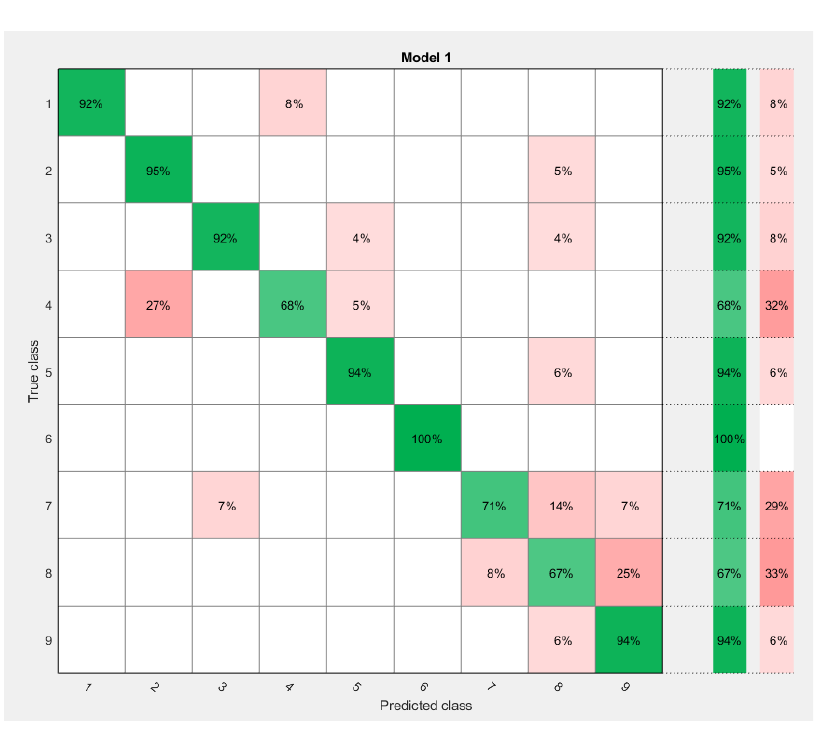
Figure 5. Confusion matrix for ANN-classifier.